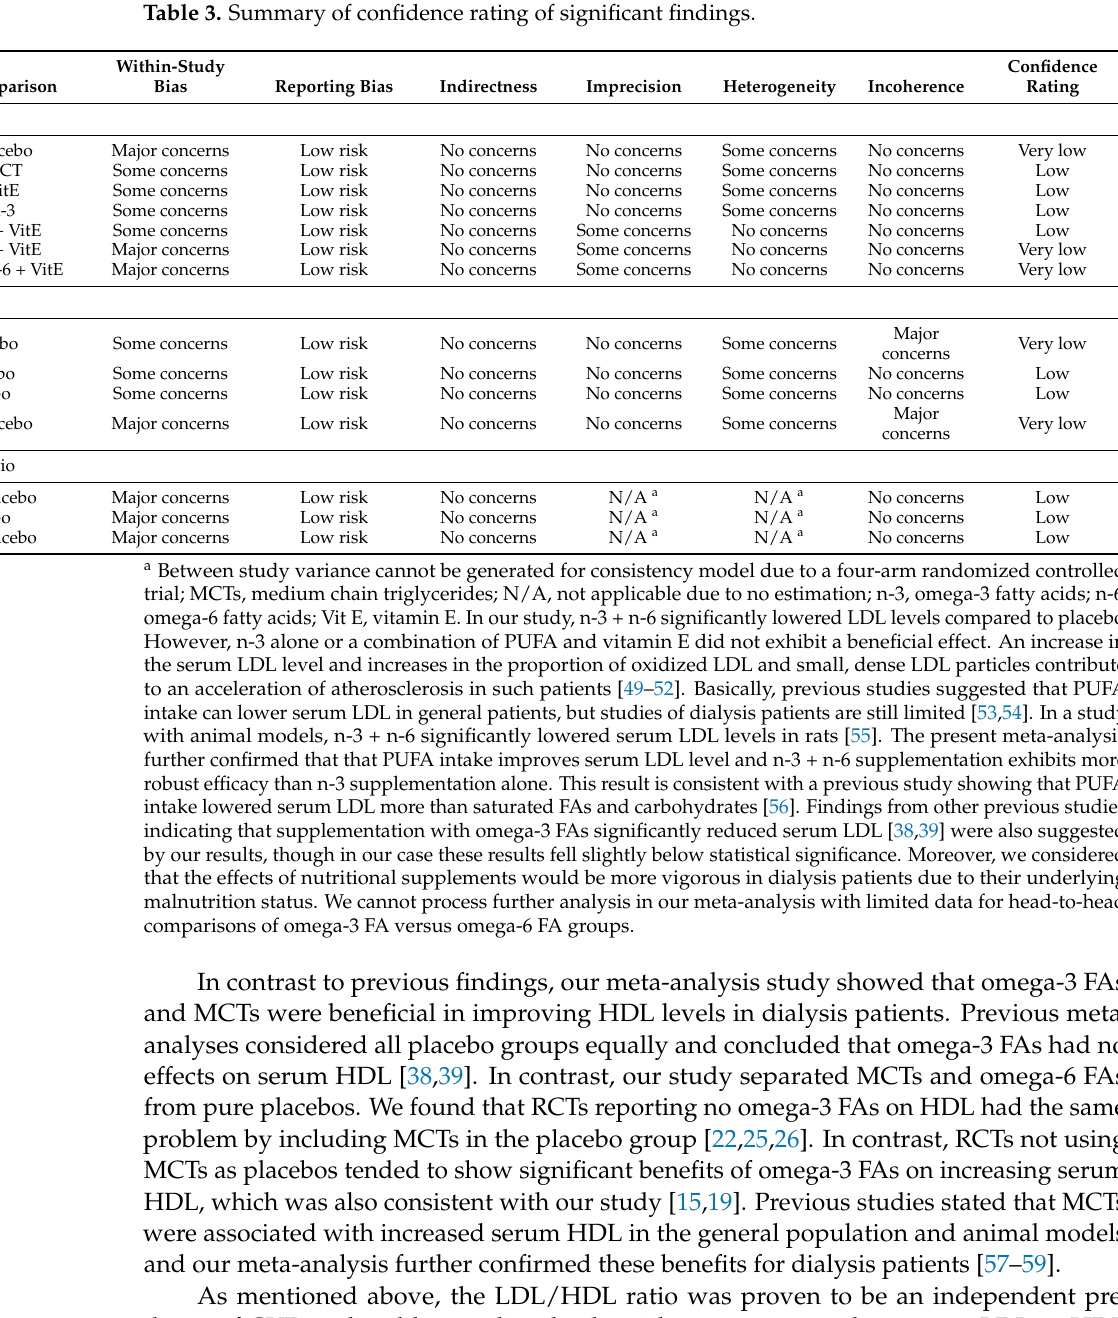
Table 3. Summary of confidence rating of significant